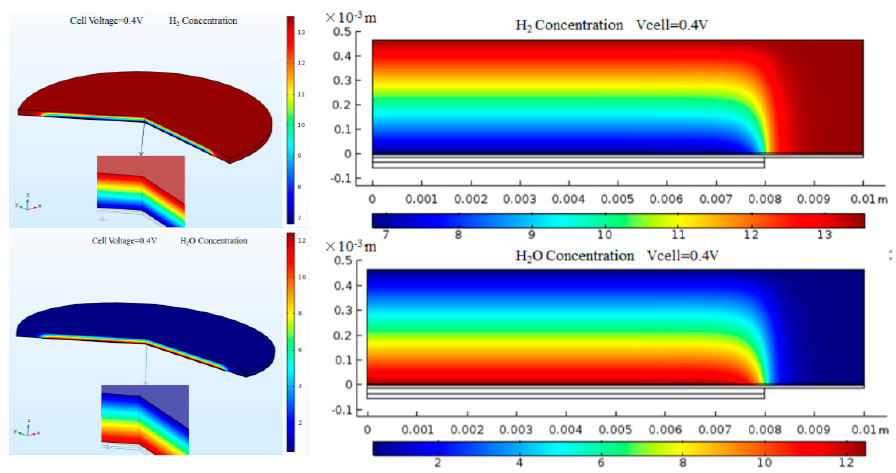
Figure 7. The concentration distributions of H 2 and H 2 O within anode at T = 600 °C and V op = 0.4 V as an example.